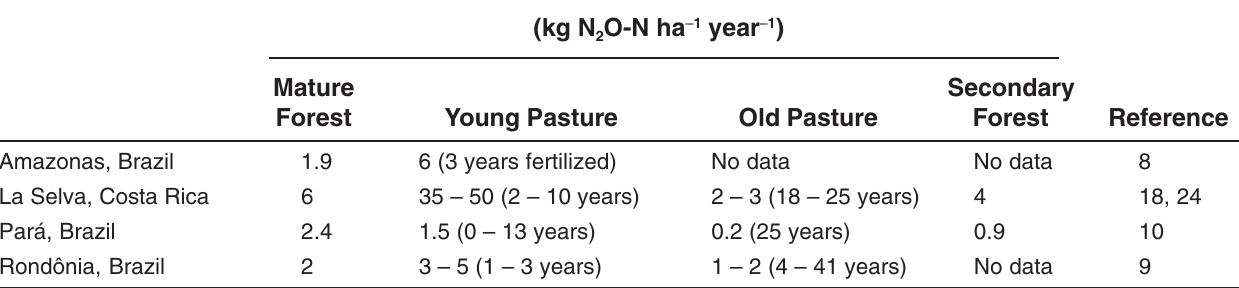
Effects of Tropical Forest-Pasture Conversion on Soil Emissions of Nitrous